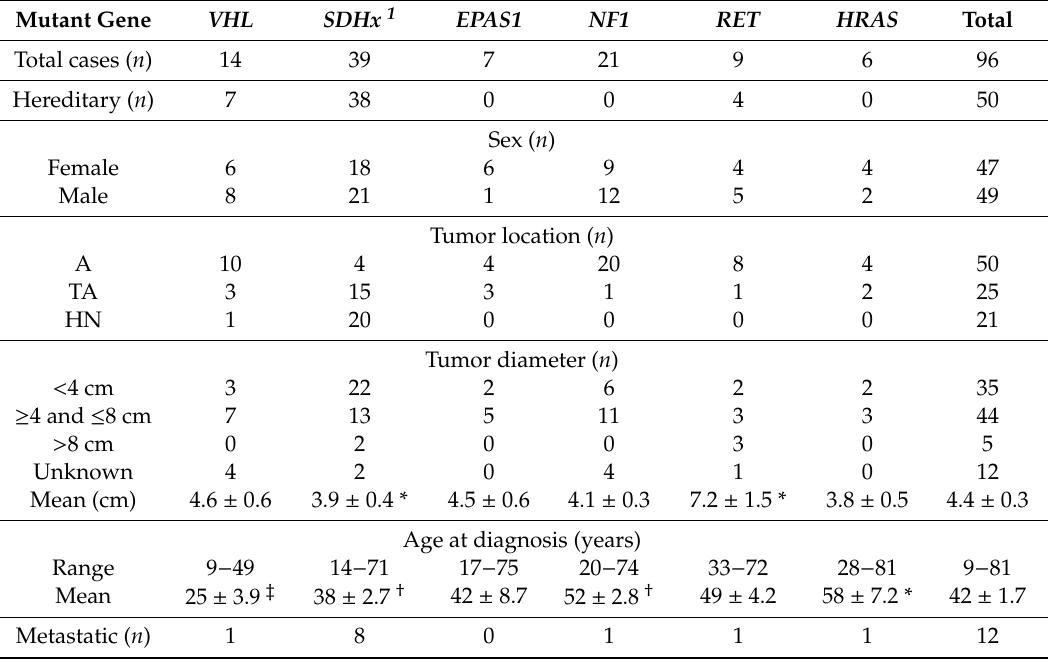
Table 2. Tumor characteristics and clinical features of 96 PPGL tissue samples available for